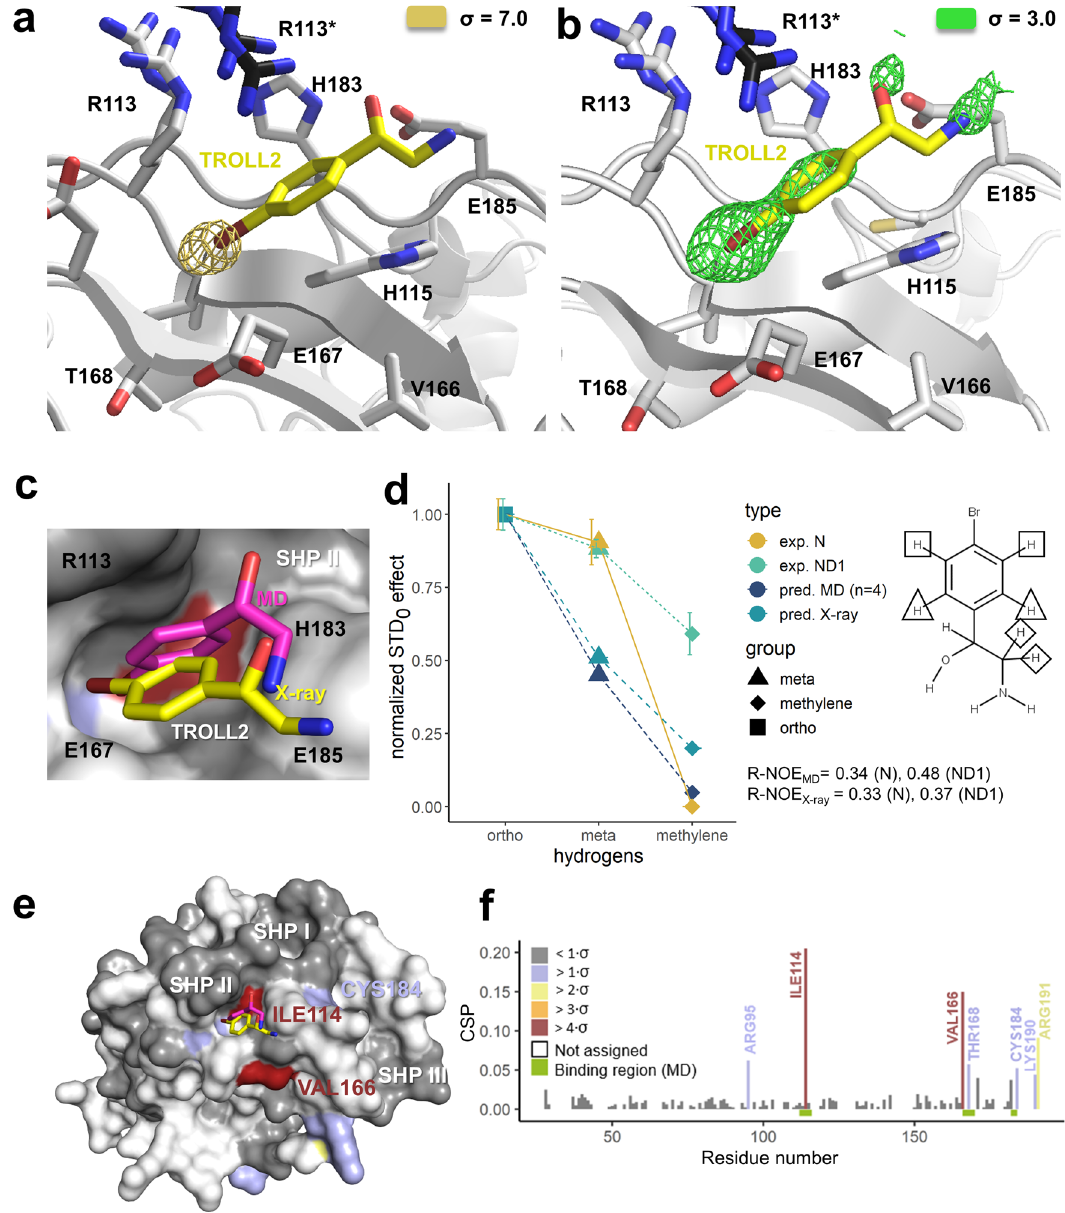
Fig. 6 Crystal structure of TROLL2 in complex with the SHP II binding site of p97-N and binding sites identi fi ed via 1 H- 15 N-HSQC NMR measurements. a Anomalous map contoured at a sigma level of 7 highlighting the single signal in the asymmetric unit, which harbors one ND1 protomer. Only the binding region superimposed with the fi nal re fi ned model is shown, with TROLL2 carbon atoms highlighted in yellow (bromine atom in dark red). b Polder omit map of TROLL2 calculated with Phenix at a sigma level of 3. c Close-up view of the SHP II region with the MD-pose in magenta and the crystal structure in yellow. d Comparison of experimental (ND1, N) and predicted STD 0 values for TROLL2 and assignment of protons visible in the STD-NMR spectra. Errors are derived from the fi tting model. e Chemical shift perturbations (CSP) mapped onto the surface representation of p97-N for TROLL2. f CSP observed for TROLL2 plotted against the primary